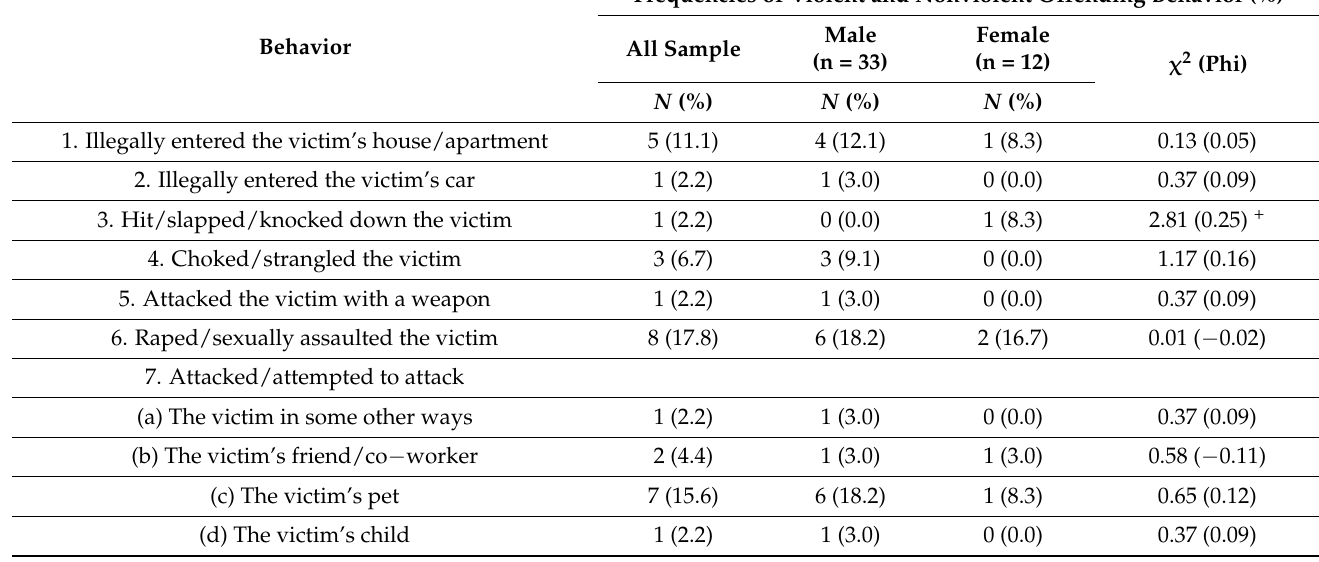
Table 4. Prevalence of violent and nonviolent offending behavior against the same victim in addition to stalking perpetration ( N =